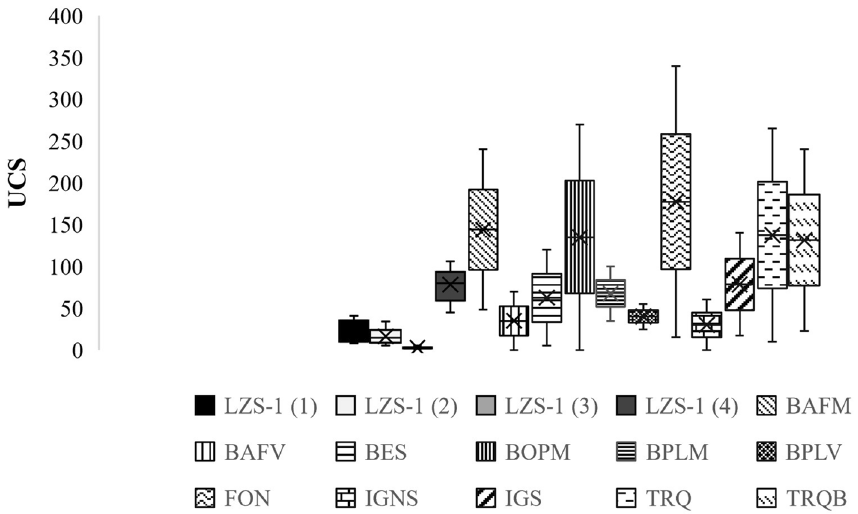
Figure 11. UCS estimation data derived from the equation obtained by Yilmaz. & Goktan 28 . BES Scoriaceous basalt, BAFV Vesicular aphanitic basalt, BOPM Massive pyrogenic olivine basalt, BPLM Massive plagioclassic basalt, FON Phonolite, IGNS Unwelded ignimbrite, TRQ Trachyte, IGS Welded ignimbrite, TRQB Trachybasalt (Modified from 20 ).